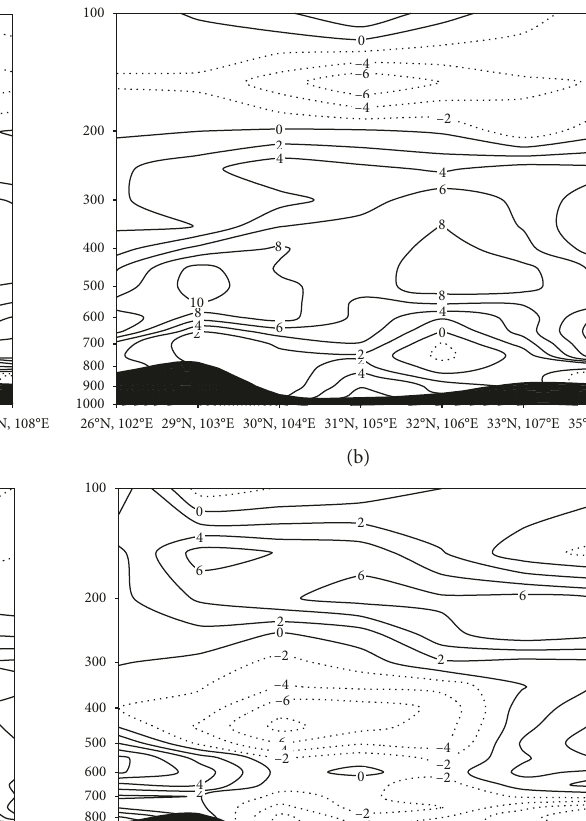
5 s 1 ) and divergence (contours, 10 − −